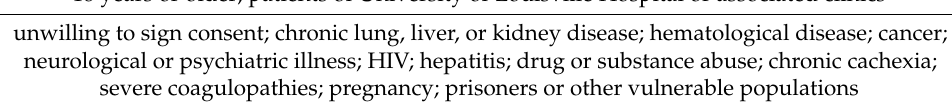
Table 7. Enrollment